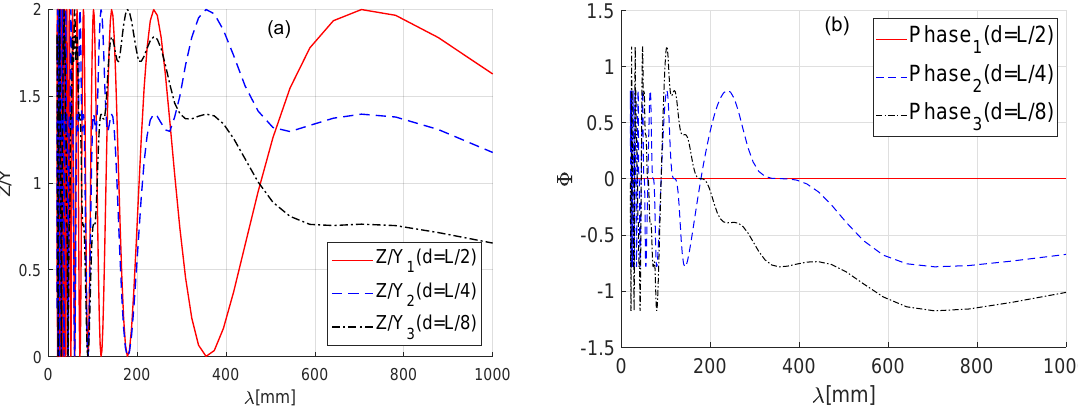
Figure 5. ( a ) Magnitude of the transfer function. ( b ) Phase angle of the transfer